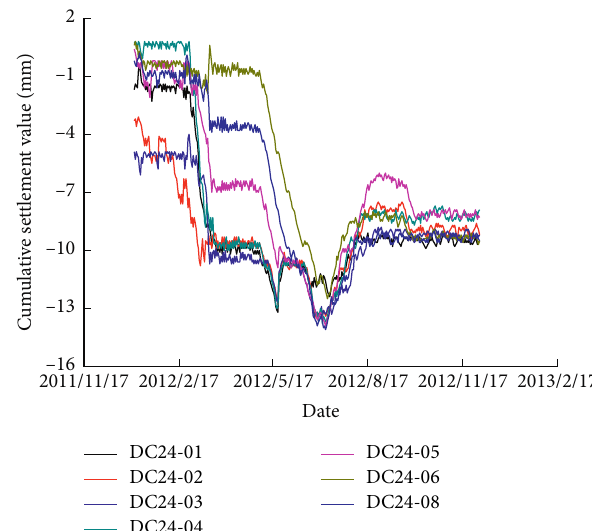
Figure 7: Settlement change curve of the construction company DC24 at Junfeng Road Station.